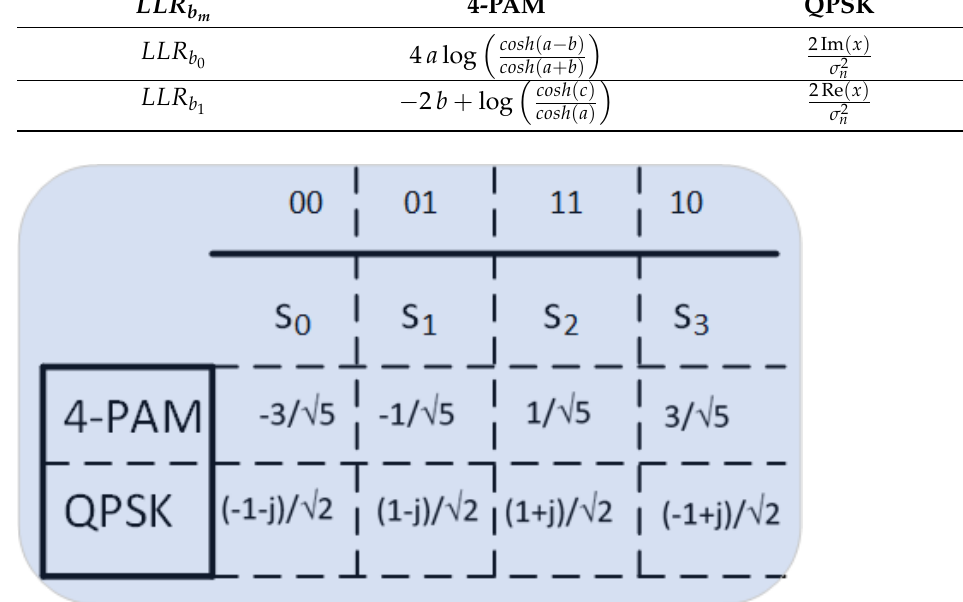
Figure 4. Gray mapping between 4-PAM and QPSK symbols performed in the satellite